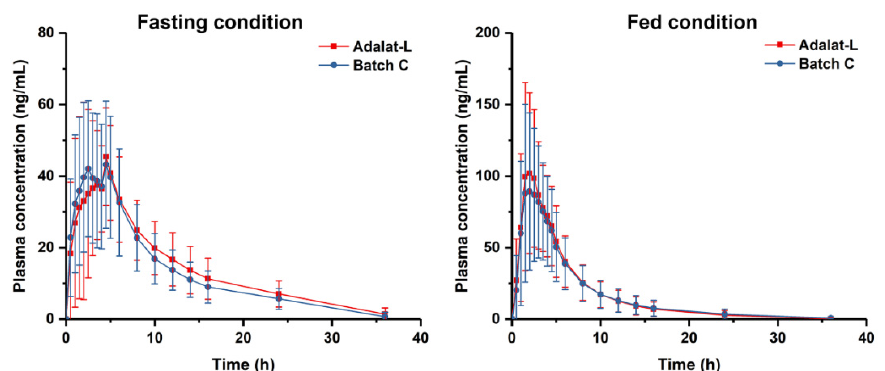
Figure 6. Plasma concentration-time profile under fasting ad fed conditions. Table 6. Pharmacokinetics parameters analysis of prepared Batch C and Adalat ® -L tablets under fasting and fed conditions.